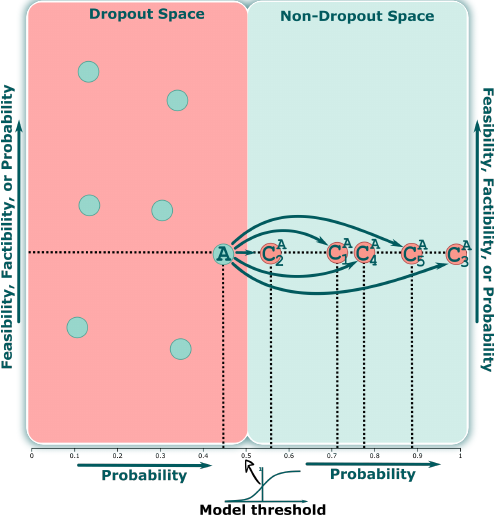
Figure 4. Representation of students and their counterfactual projections in the probability space. The left side shows the students, while the right side shows the counterfactuals based on their probability of belonging to the non-dropout class. The classification model gives the probability.